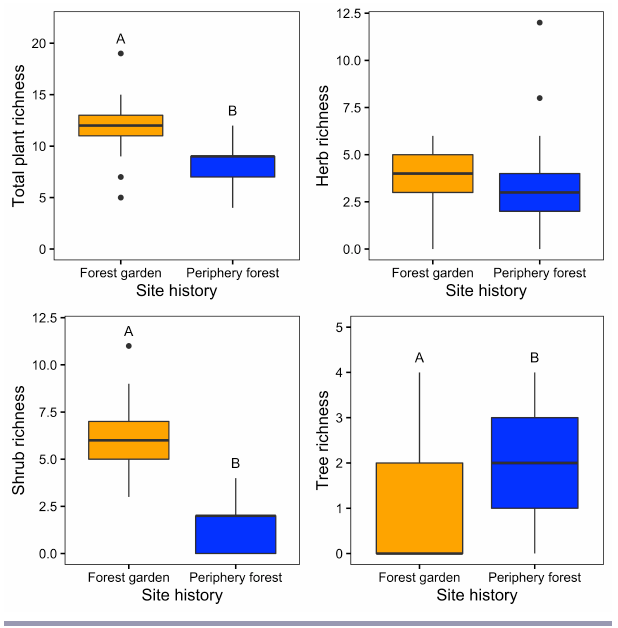
Fig. 3 . Total Species Richness and Species Richness by Lifeform. Richness is indicated overall between forest gardens and periphery forests (averaged across the four of the study areas) and among the three growth forms (trees, shrubs and herbs).